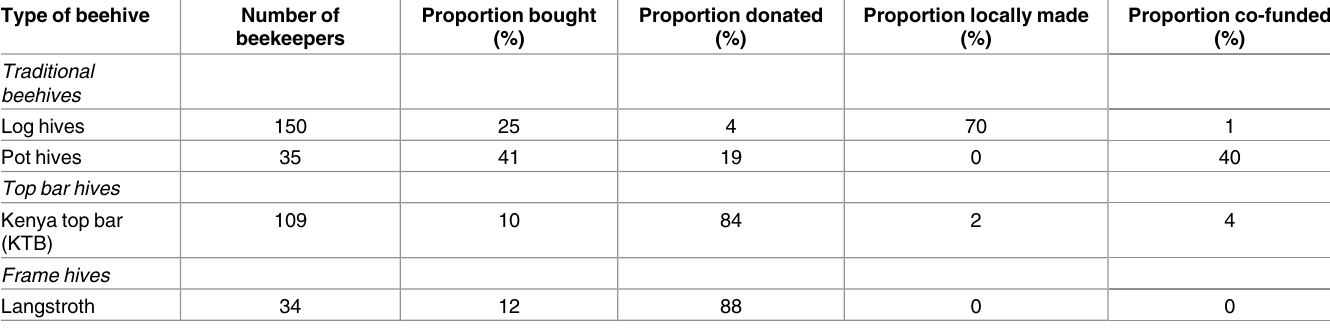
Table 7. Provision of